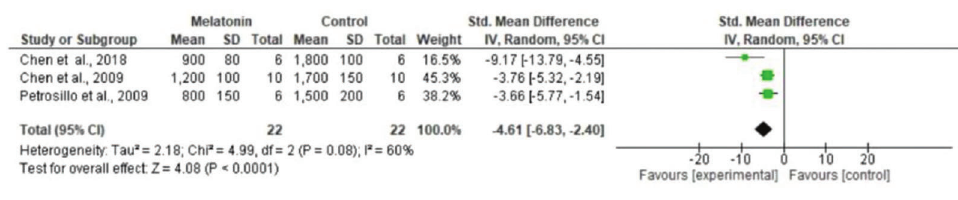
Figure 3c - Metanalysis of lactate dehydrogenase (U/L).